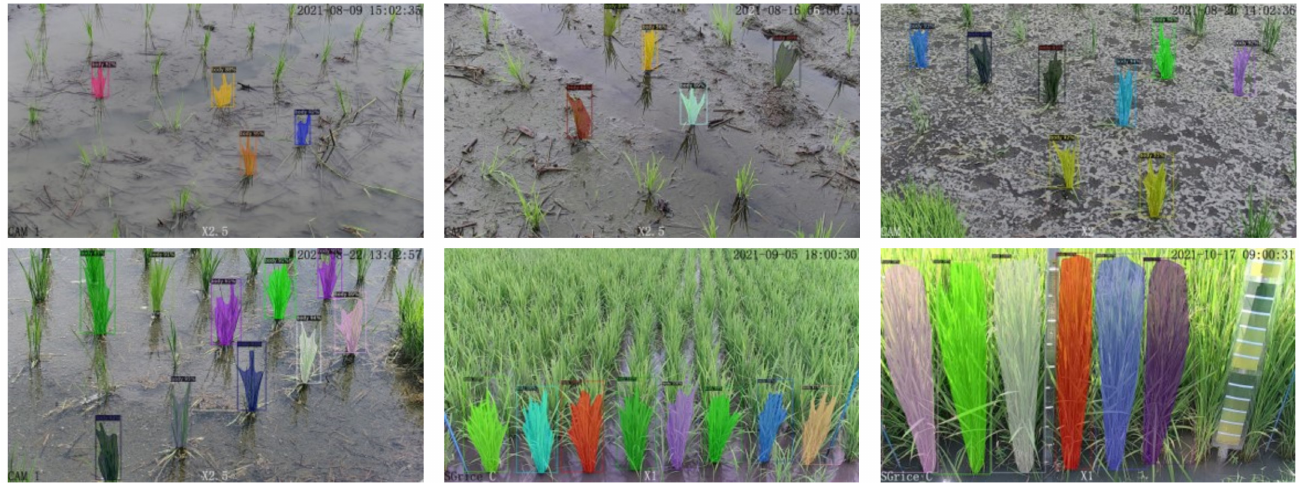
Figure 11. Model’s Predicted